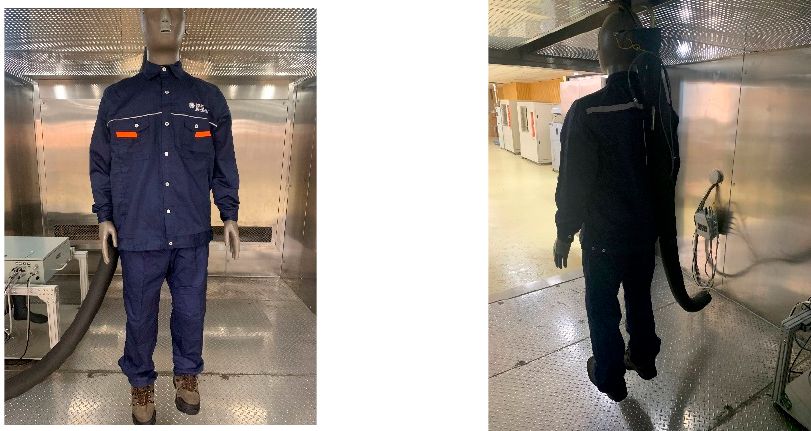
Figure 1. The thermal manikin Newton with power grid ensembles.